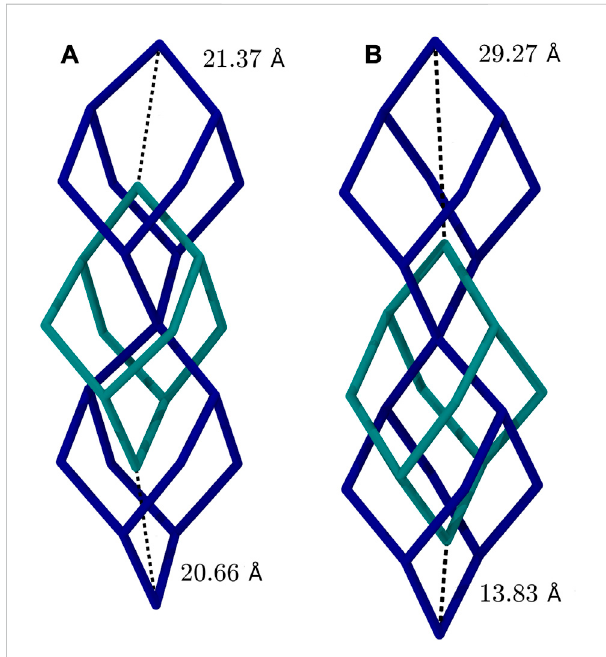
FIGURE 3 Comparison of 3D-HNU5 structures in two-fold interpenetrated diamond topology loaded with 10.4 w% CO 2 , (A) at 77.15 K, (B) at 273.15 K. Each bond represents an entire azine linking unit, that connects two central carbon